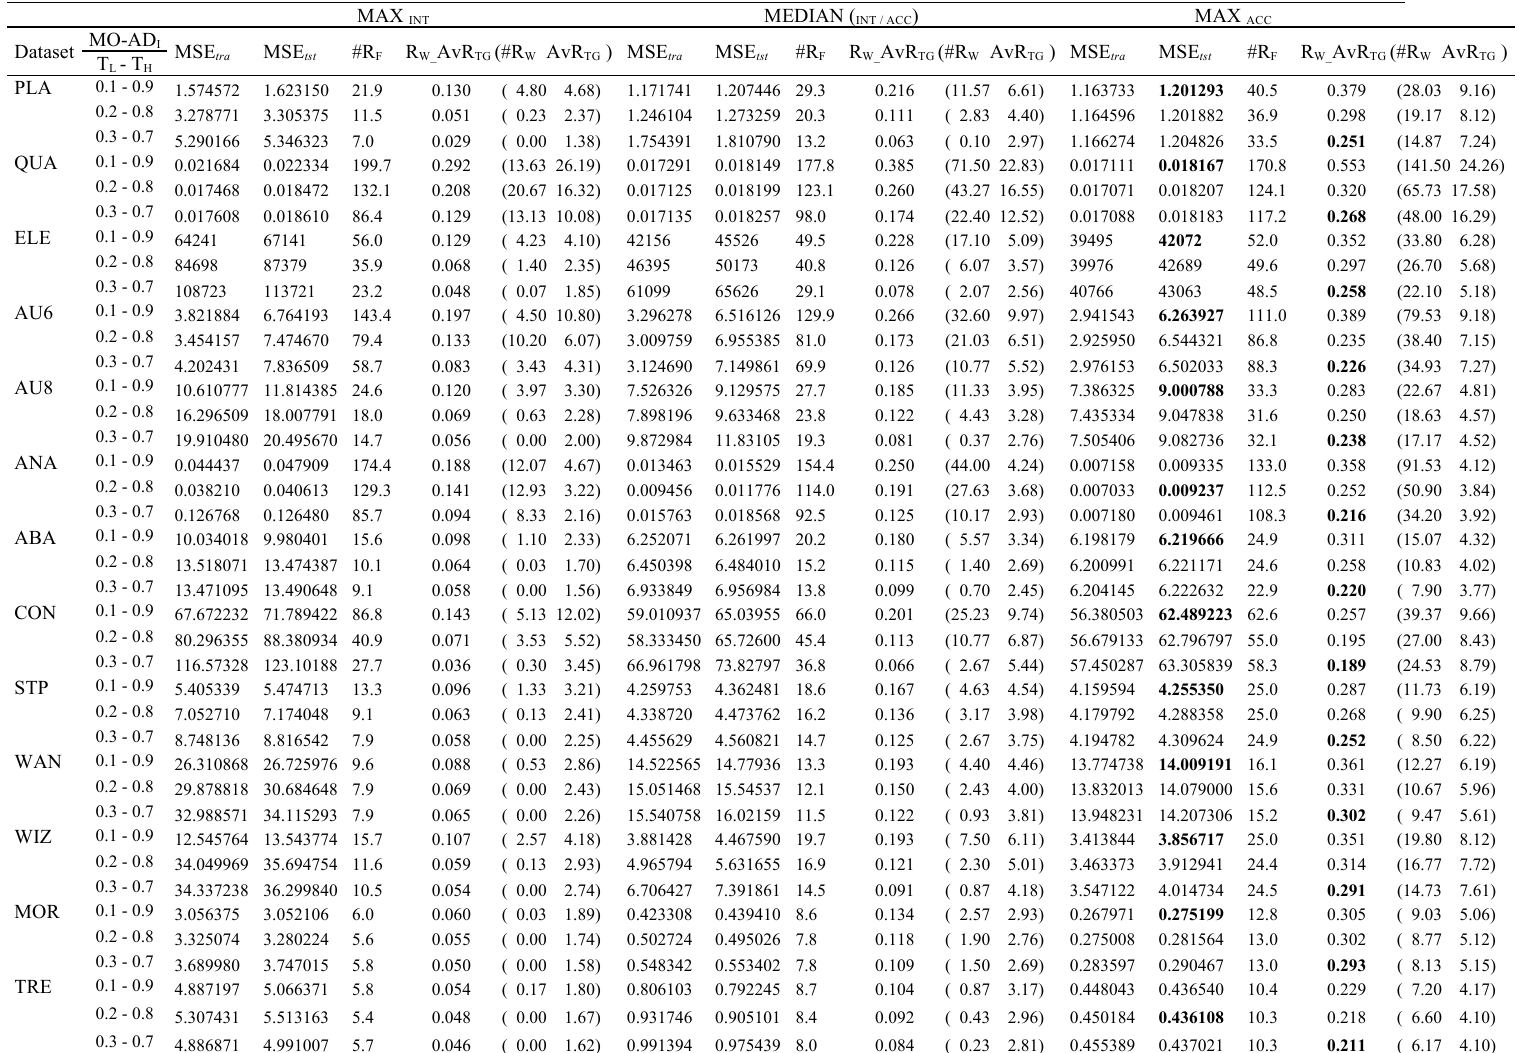
Table 6. Results obtained by MO-AD I for different configurations of thresholds using the FS_MOGUL rule